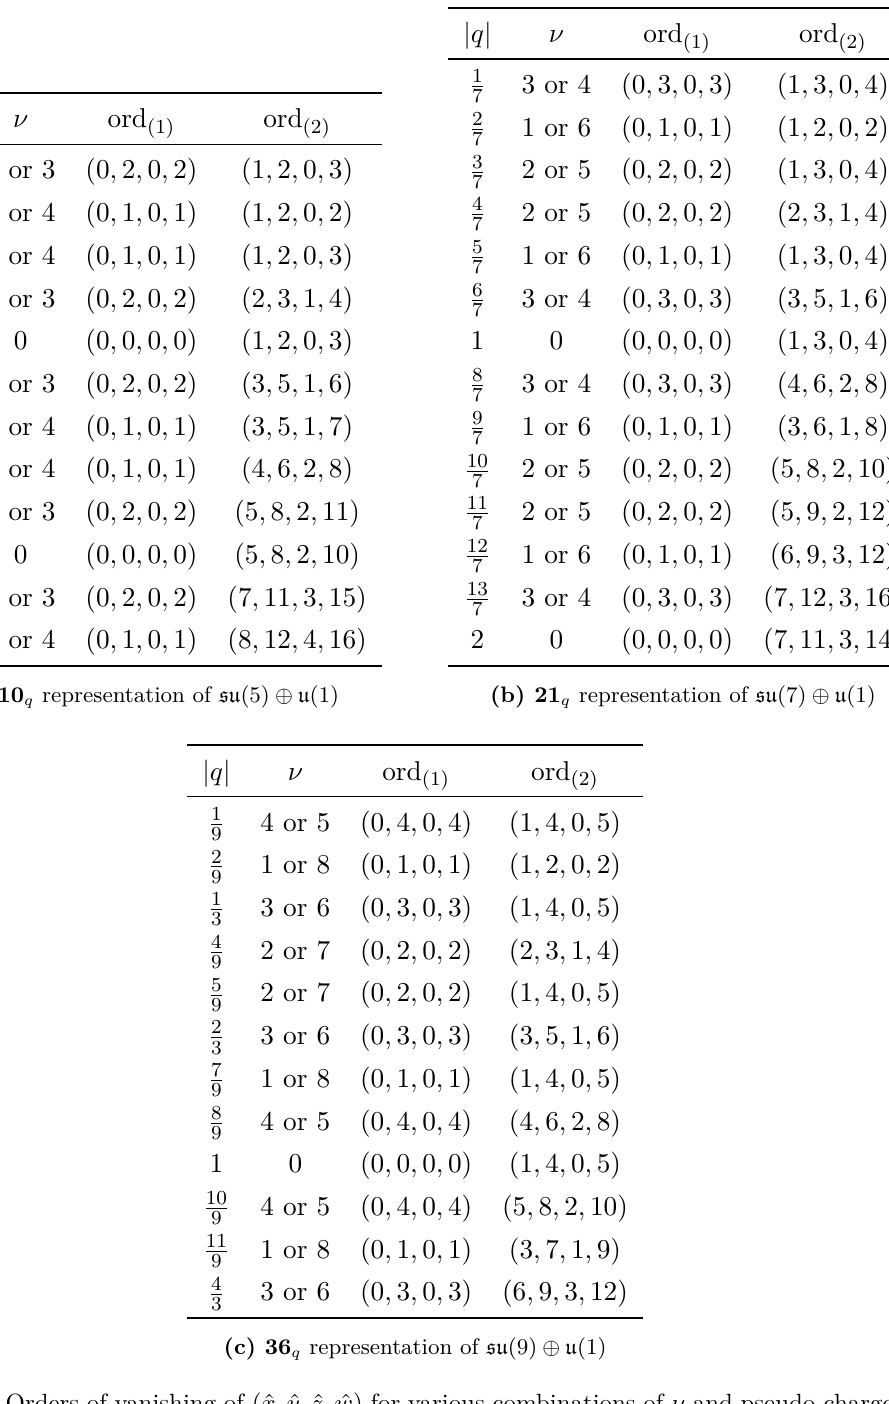
Table 12. Orders of vanishing of (ˆ x, ˆ y, ˆ z, ˆ w ) for various combinations of ν and pseudo-charge q for antisymmetric matter of su (2 k + 1) ⊕ u (1) . The data are found using the model in eq.